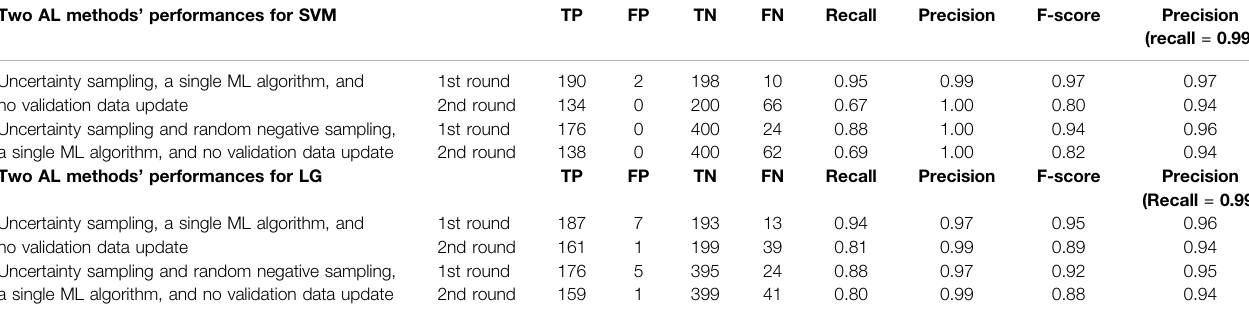
TABLE 3 | Performances (SVM and LR) of two active learning methods with single machine learning (ML) algorithms. Two AL methods ’ performances for SVM